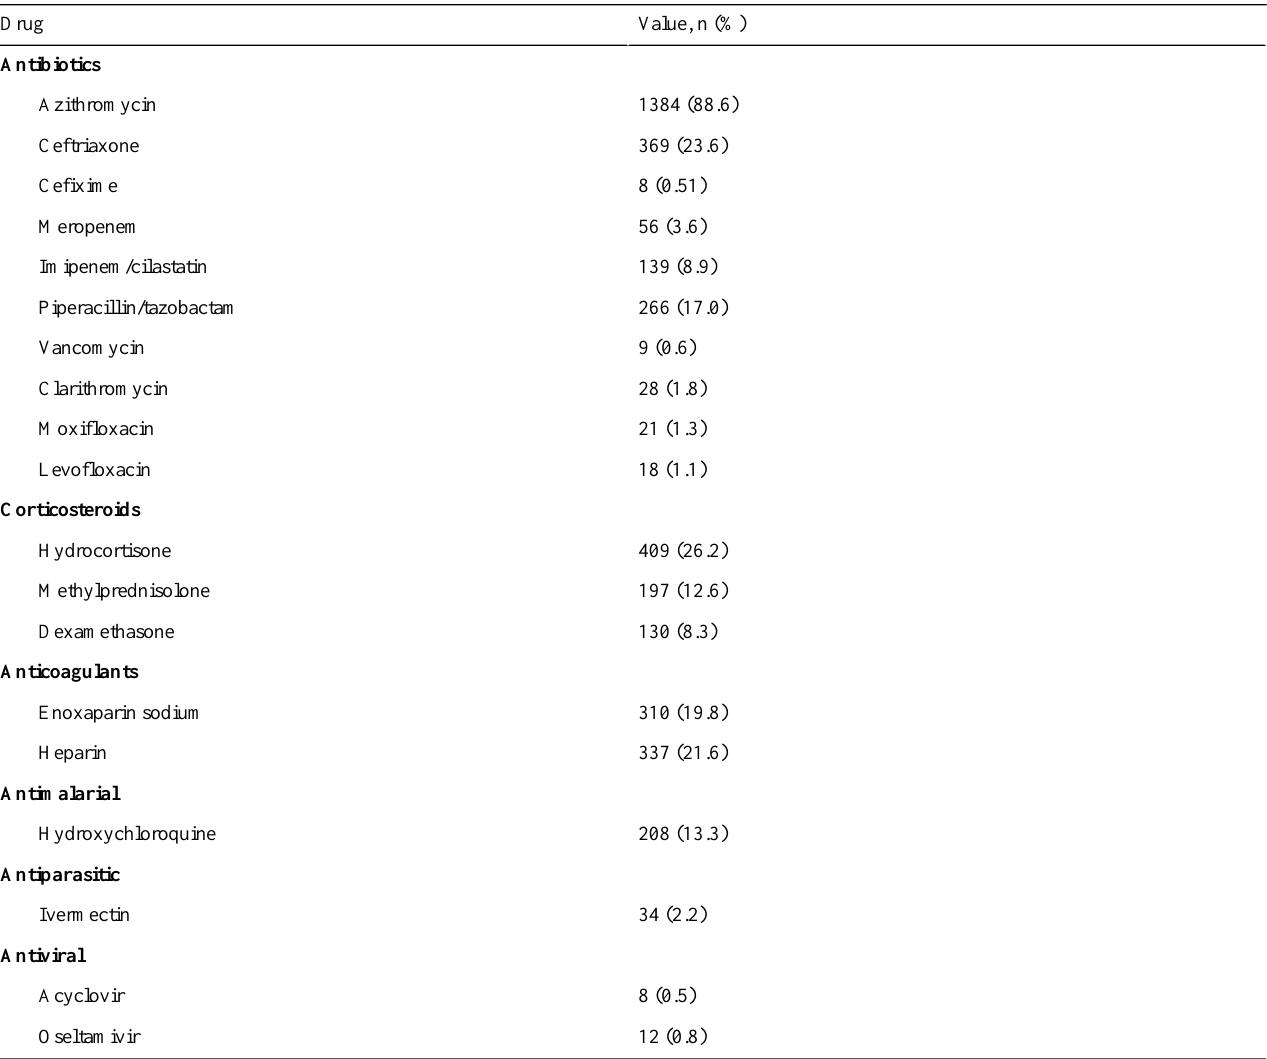
Table 3. Drugs used during the first wave of COVID-19 to treat patients (N=1562) in all four hospitals under